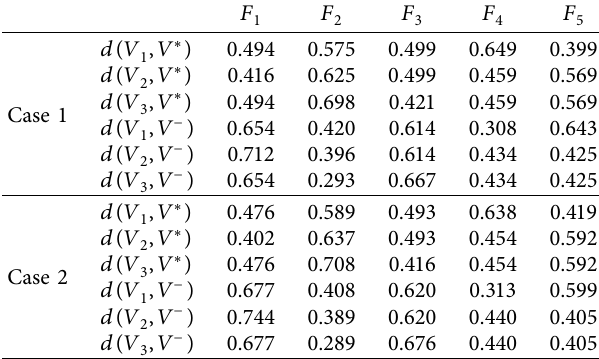
Table 4: Distance between V to each candidate.